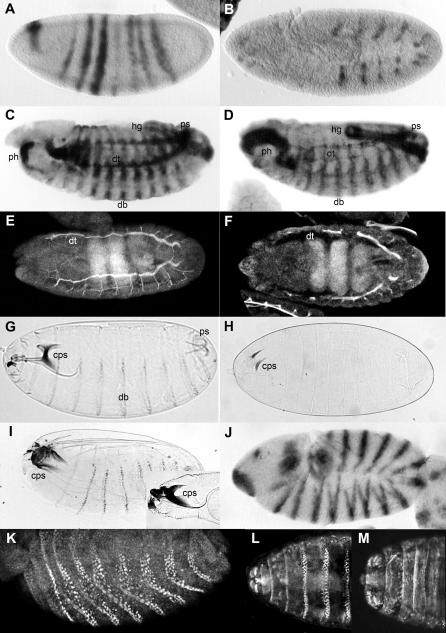

tal Is Required for Embryonic Development(A–D) Expression of tal RNA throughout embryogenesis. (A) Expression of tal starts in seven blastodermal stripes and a cluster of cells in the anterior part of the embryo. (B) This expression refines to the tracheal precursors by the extended germ band stage. (C and D) Later, tal is present in the dorsal tracheal trunks (dt), posterior spiracles (ps), pharynx (ph), hindgut (hg), and presumptive denticle belts (db).(E) Dorsal tracheal trunks (dt) in a stage 16 wild-type embryo (dorsal view) revealed by the detection of the chitin binding protein.(F) Gaps in the dorsal tracheal trunks of a tal mutant.(G) Wild-type embryo cuticle: cephalopharyngeal skeleton (cps), ventral denticle belts (db), and posterior spiracles (ps).(H) In tal null mutants, these cuticular structures are missing or reduced.(I) Ectopic tal expression in the head produces extra cephalopharyngeal skeleton (ventral view; inset shows lateral view).(J) Wg protein distribution in the epidermis is normal in an extended germ band tal mutant embryo.(K) Expression of a shaven-baby reporter gene in ventral epidermis is not affected in a stage 17 tal mutant embryo. tal expression is not affected either in svb mutants (unpublished data).(L) Ventral view of the anterior-most segments of a stage 16 wild-type embryo. The denticle cells of the epidermis accumulate tubulin bundles prior to any denticle cuticle structures being observed.(M) In tal mutants, these tubulin bundles do not form.